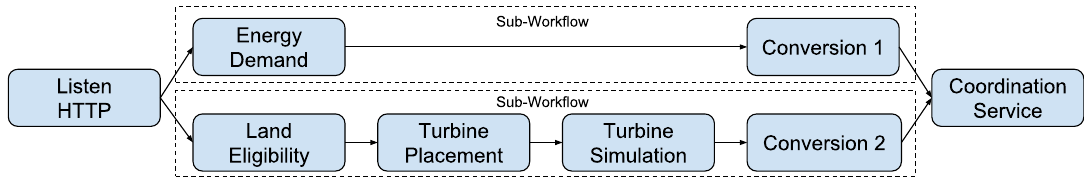
Figure 6. Use case: model workflow for designing a cross-regional energy